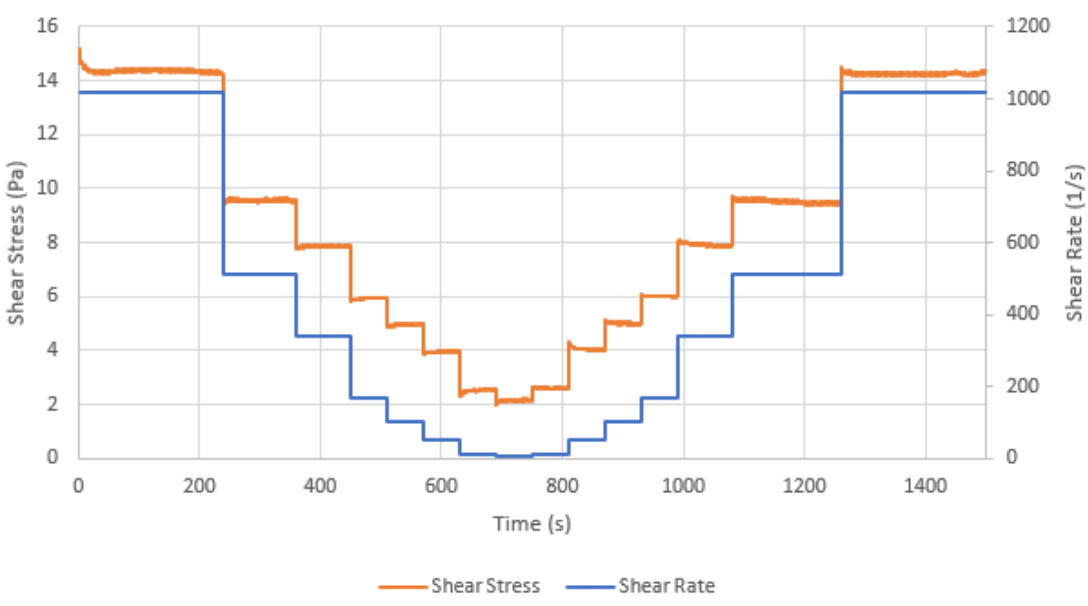
Figure 15. With a thixotropic fluid, it is noticeable that the shear stress stabilizes to a steady state value after several tens of seconds each time the rheometer speed is changed.